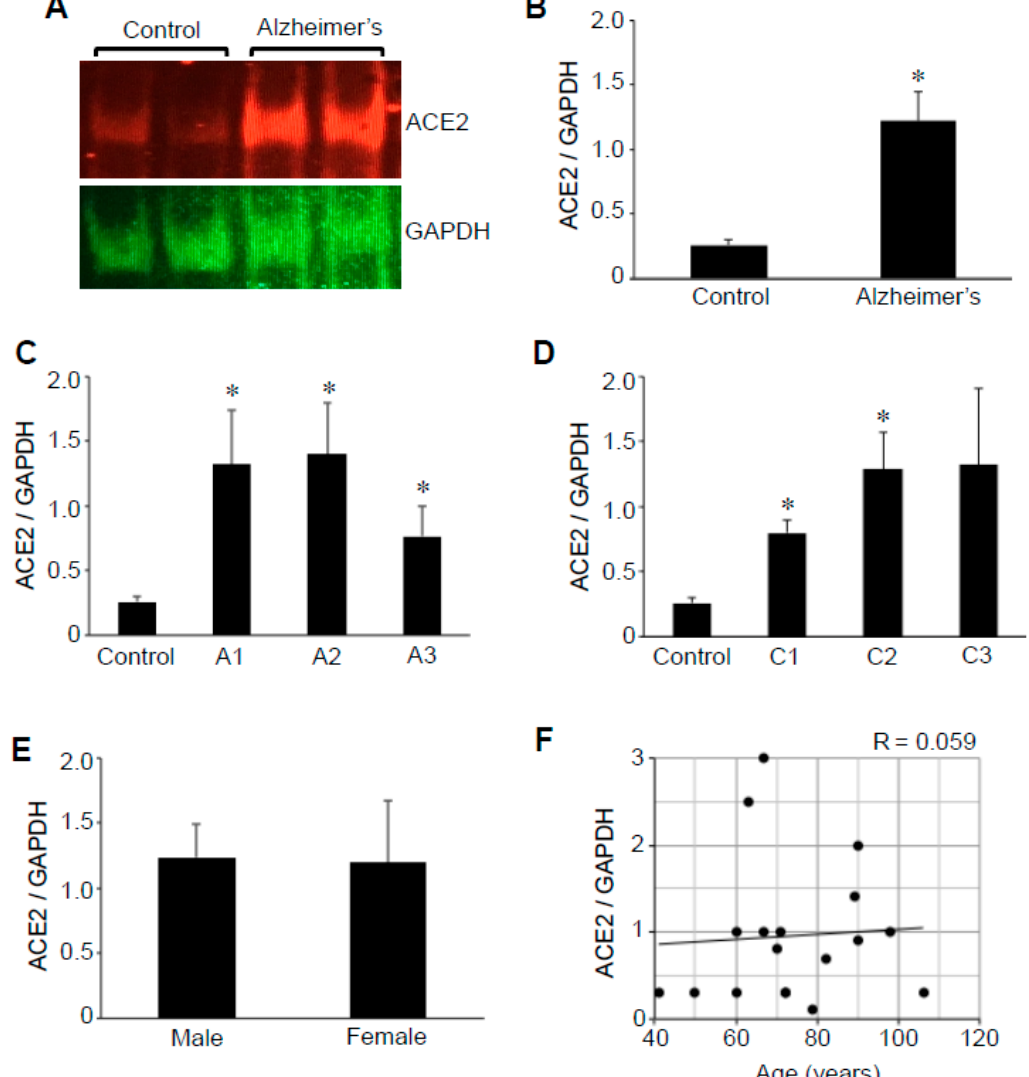
Figure 1. The ACE2 protein expression is upregulated in the brains of patients with Alzheimer’s disease. Brain (hippocampus) homogenates from control subjects and patients with Alzheimer’s disease were subjected to Western blotting using antibodies against ACE2 and GAPDH. ( A ) Representative results. ( B ) The bar graph represents means ± SEM of the ratio of ACE2 to GAPDH (N = 13 for Alzheimer’s and 5 for control). ( C ) The bar graph represents means ± SEM of the ratio of ACE2 to GAPDH for various A β plaque scores (denoted by the letter A). N = 5 for control, 5 for A1, 5 for A2, and 3 for A3. ( D ) The bar graph represents means ± SEM of the ratio of ACE2 to GAPDH for various neuritic plaque scores (denoted by the letter C). N = 5 for control, 2 for C1, 7 for C2, and 4 for C3. The symbol * denotes that the value is significantly different from the control value at p < 0.05. ( E ) The bar graph represents means ± SEM of the ratio of ACE2 to GAPDH (N = 8 for male and 5 for female). No significant difference was found between males and females. ( F ) The scattered graph represents age vs. ACE2 expression (N = 18). Pearson correlation coefficient R = 0.059 (weak positive correlation).